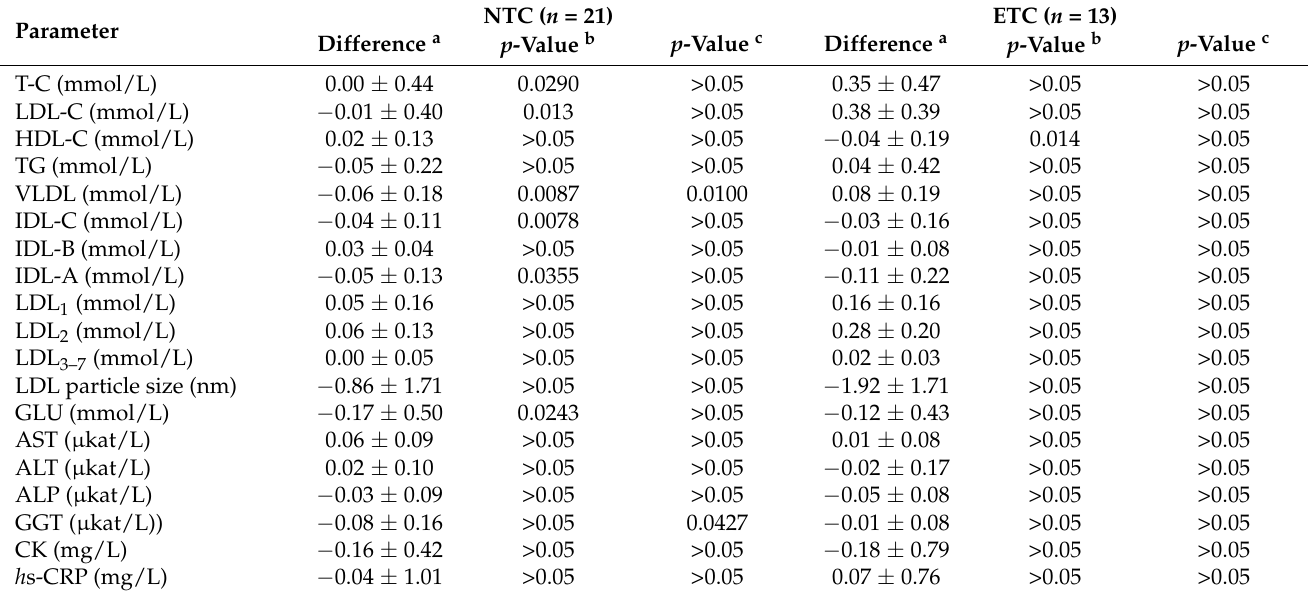
Table 7. Changes of monitored parameters after nutrition intervention adjusted for body mass index (BMI) and